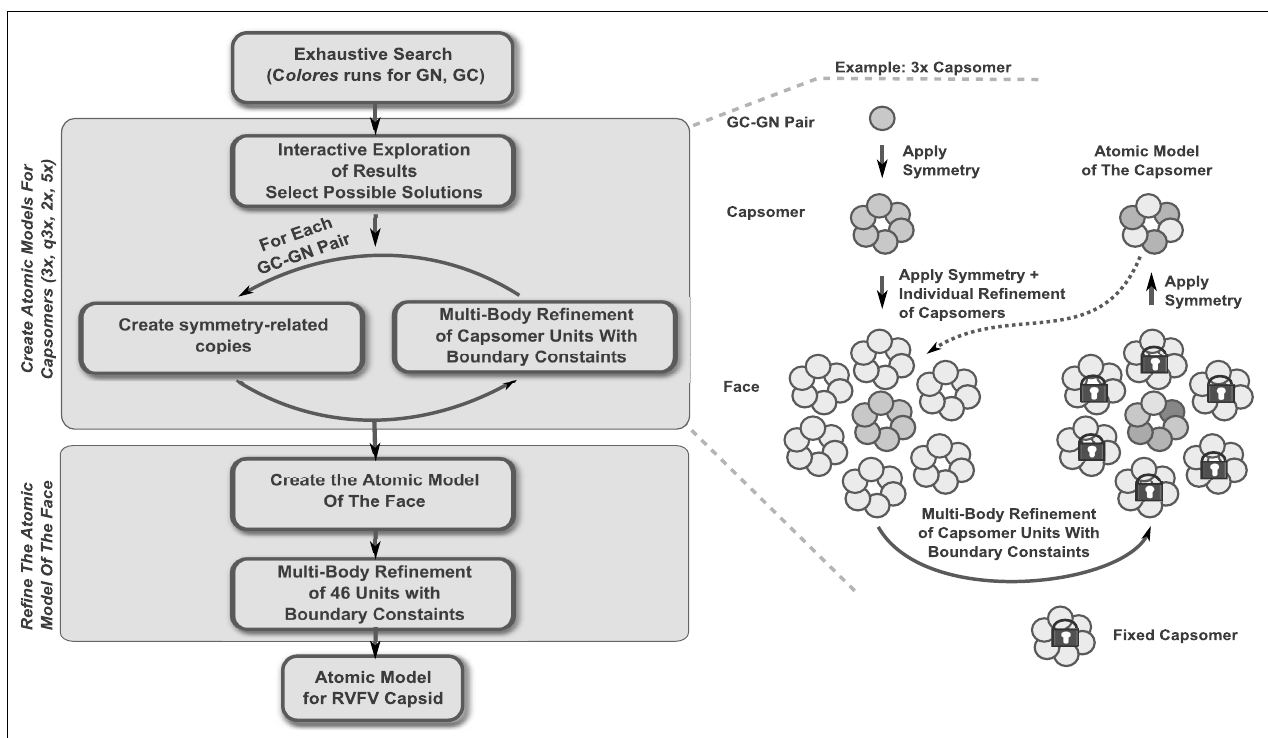
FIGURE 2 | Schematic representation of the modeling steps undertaken to create the atomic model of the RVFV envelope. A detailed description of the individual steps is found in the